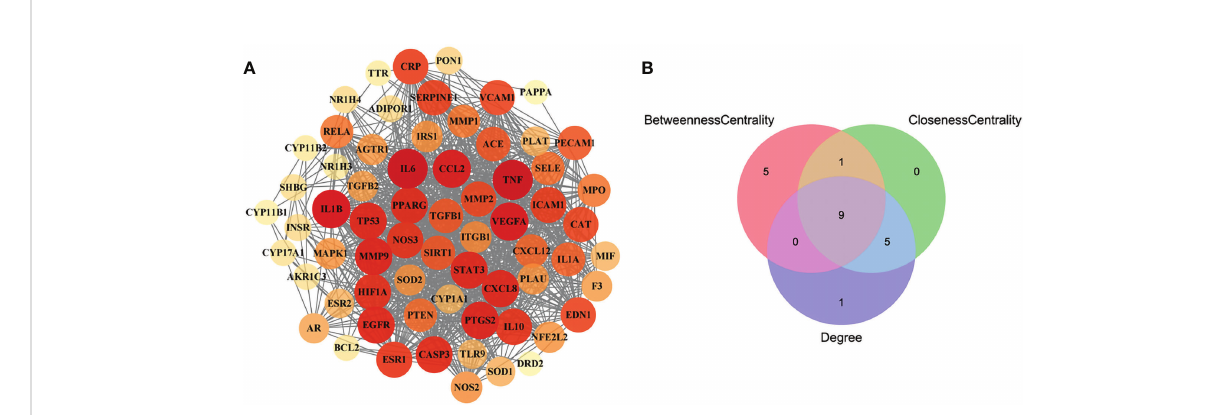
FIGURE 3 The PPI network of the intersecting targets of RSV and PE and the topological parameters analysis of the PPI network. (A) The PPI network of the intersecting targets of RSV and PE. (B) The Venn diagram of the top 15 proteins of each topological parameter. Nine proteins located in the central region were identi fi ed as the hub targets. The red circle represents the top 15 proteins of betweenness centrality, the green circle represents the top 15 proteins of closeness centrality, and the blue circle represents the top 15 proteins of degree. PPI, protein – protein interaction; RSV, resveratrol; PE, preeclampsia.